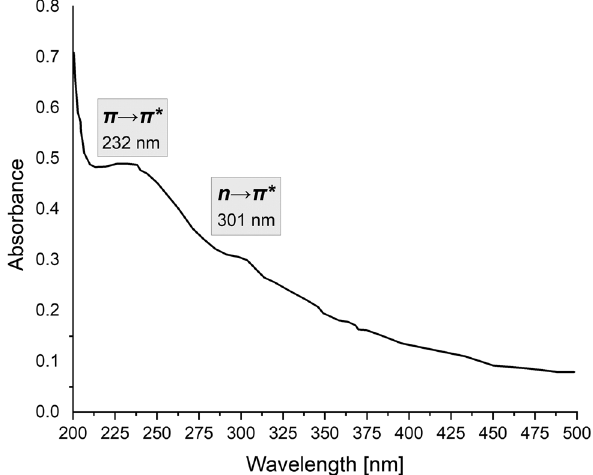
Figure 2: UV - Vis absorption spectra of GO in DI